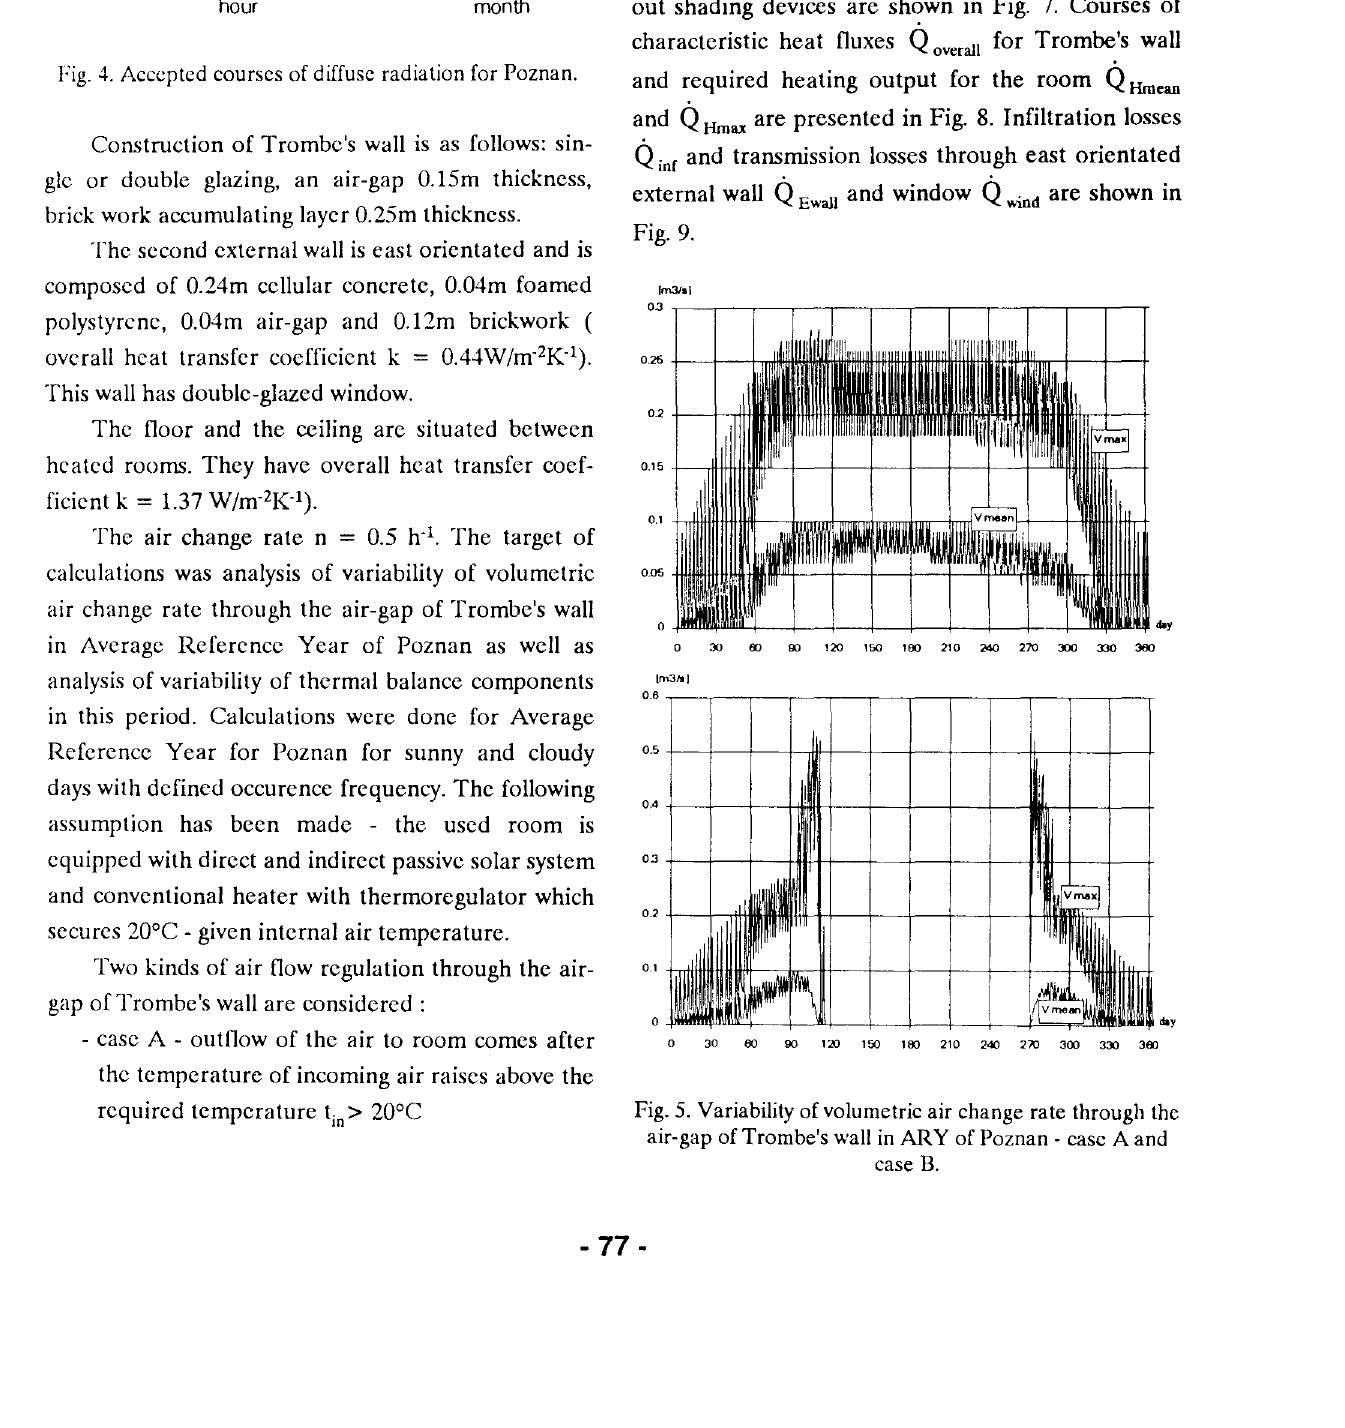
Fig. 4. Accepted courses of diffuse radiation for Poznan.